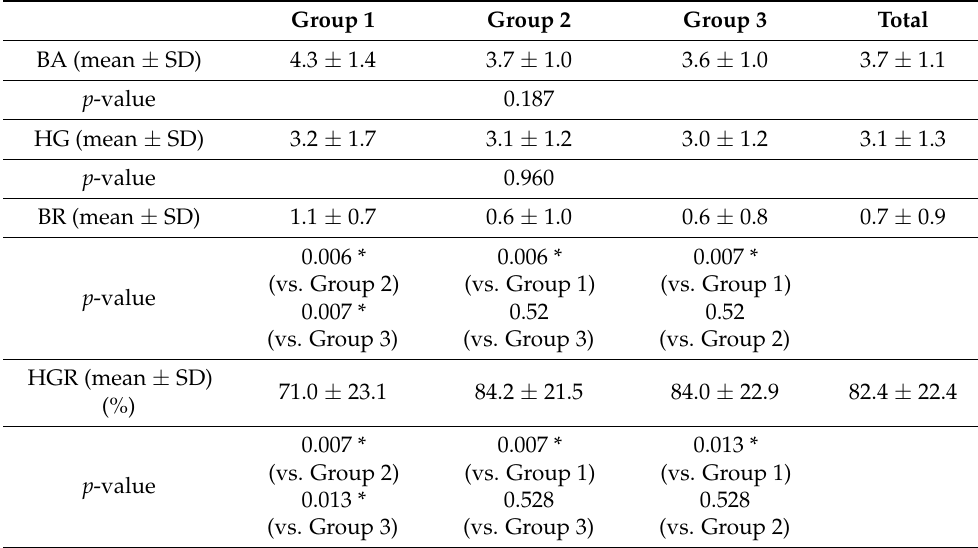
Table 3. Radiological assessment of the BA, HG, BR and HGR of the